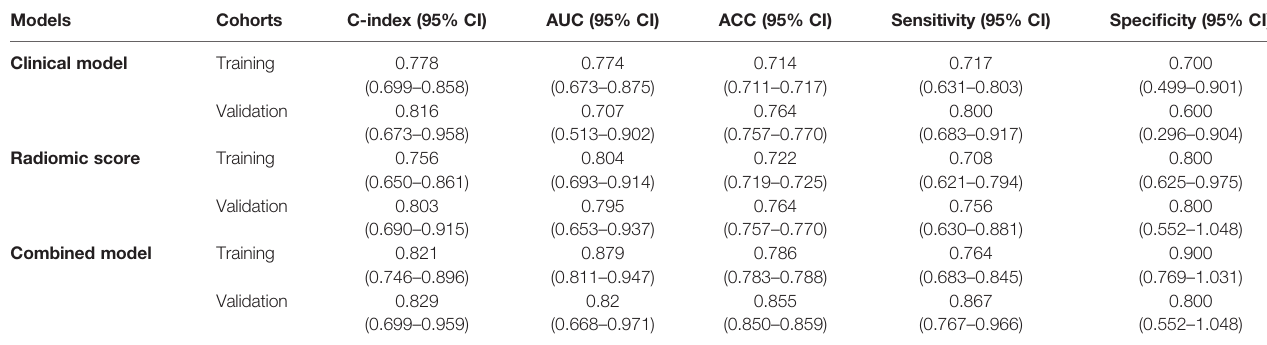
TABLE 2 | Model performance on predicting 3-year PFS.